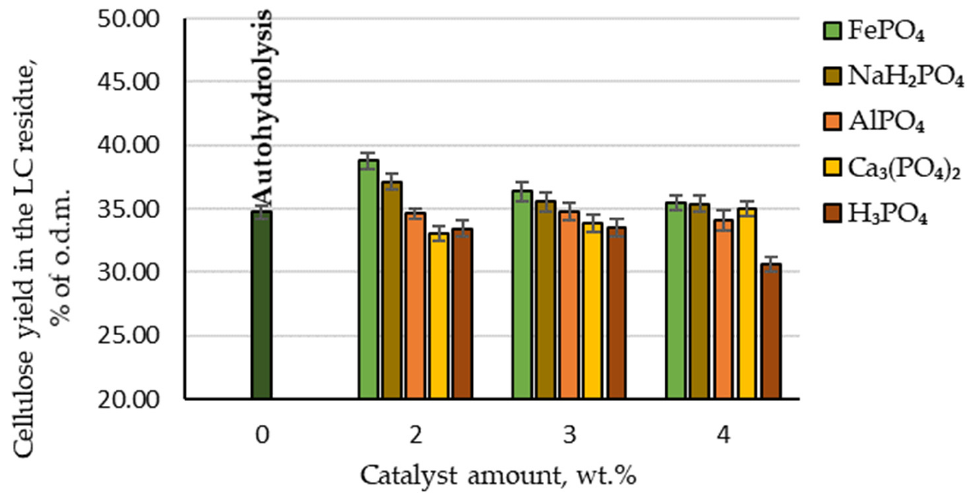
Figure 5. Amounts of cellulose retained in the LC residue depending on the catalyst amount.